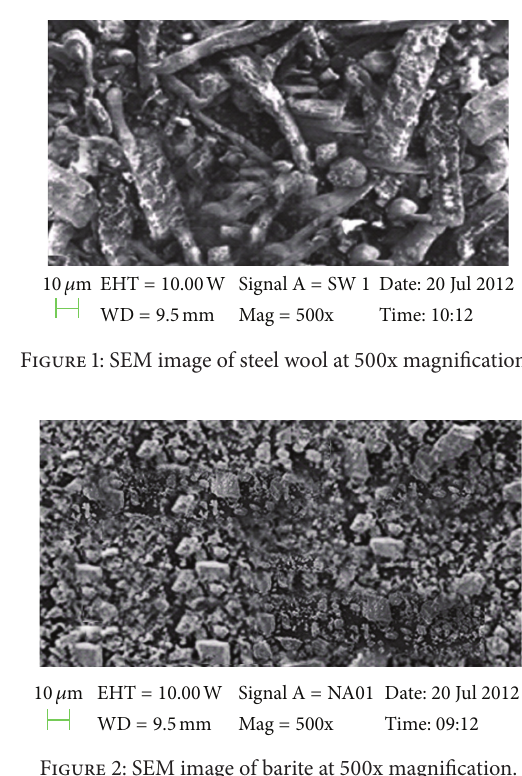
Figure 2: SEM image of barite at 500x